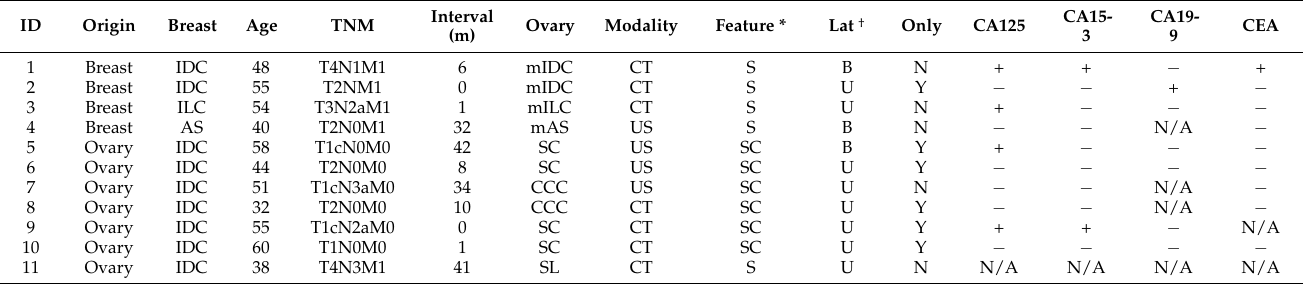
Table 2. Clinicopathological features of the malignant ovarian